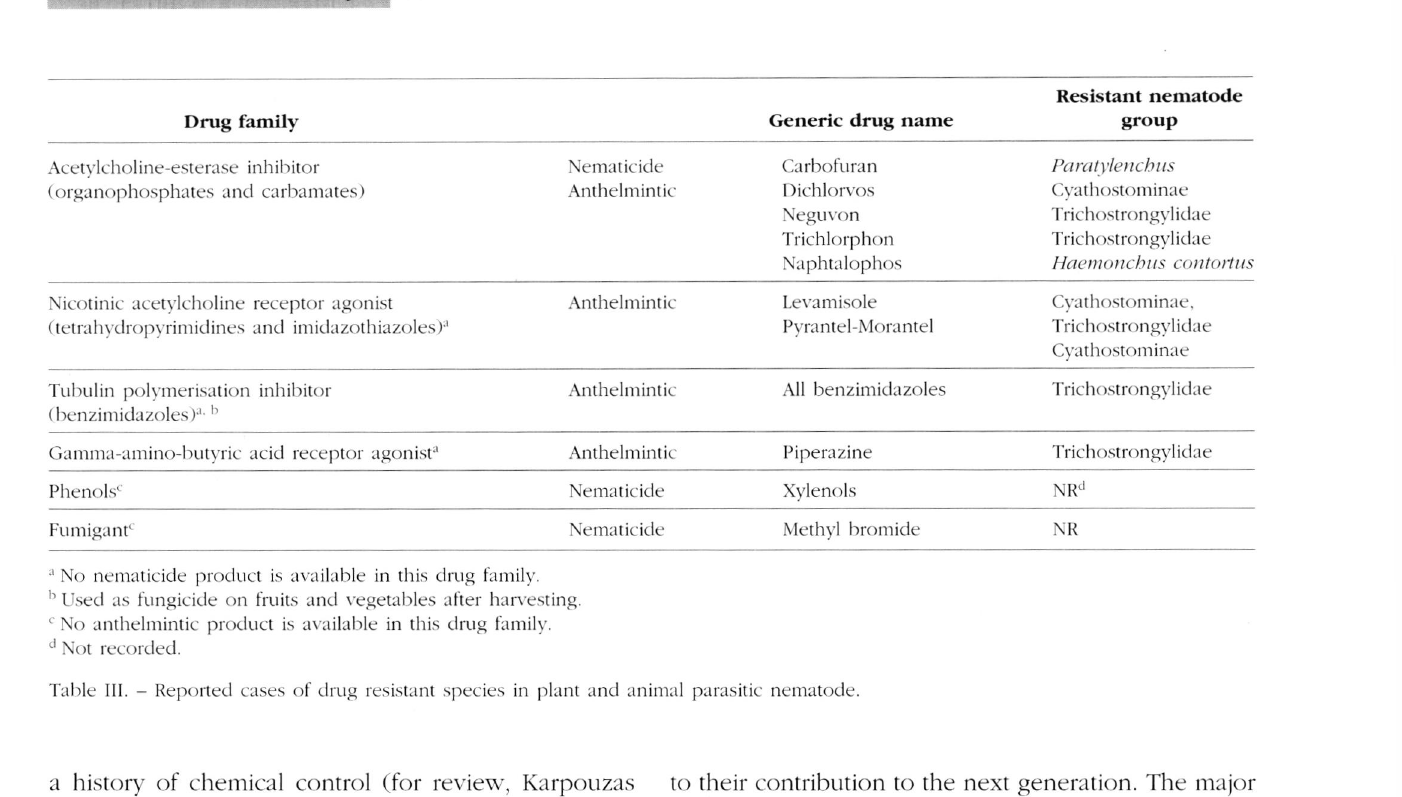
Table III. – Reported cases of drug resistant species in plant and animal parasitic